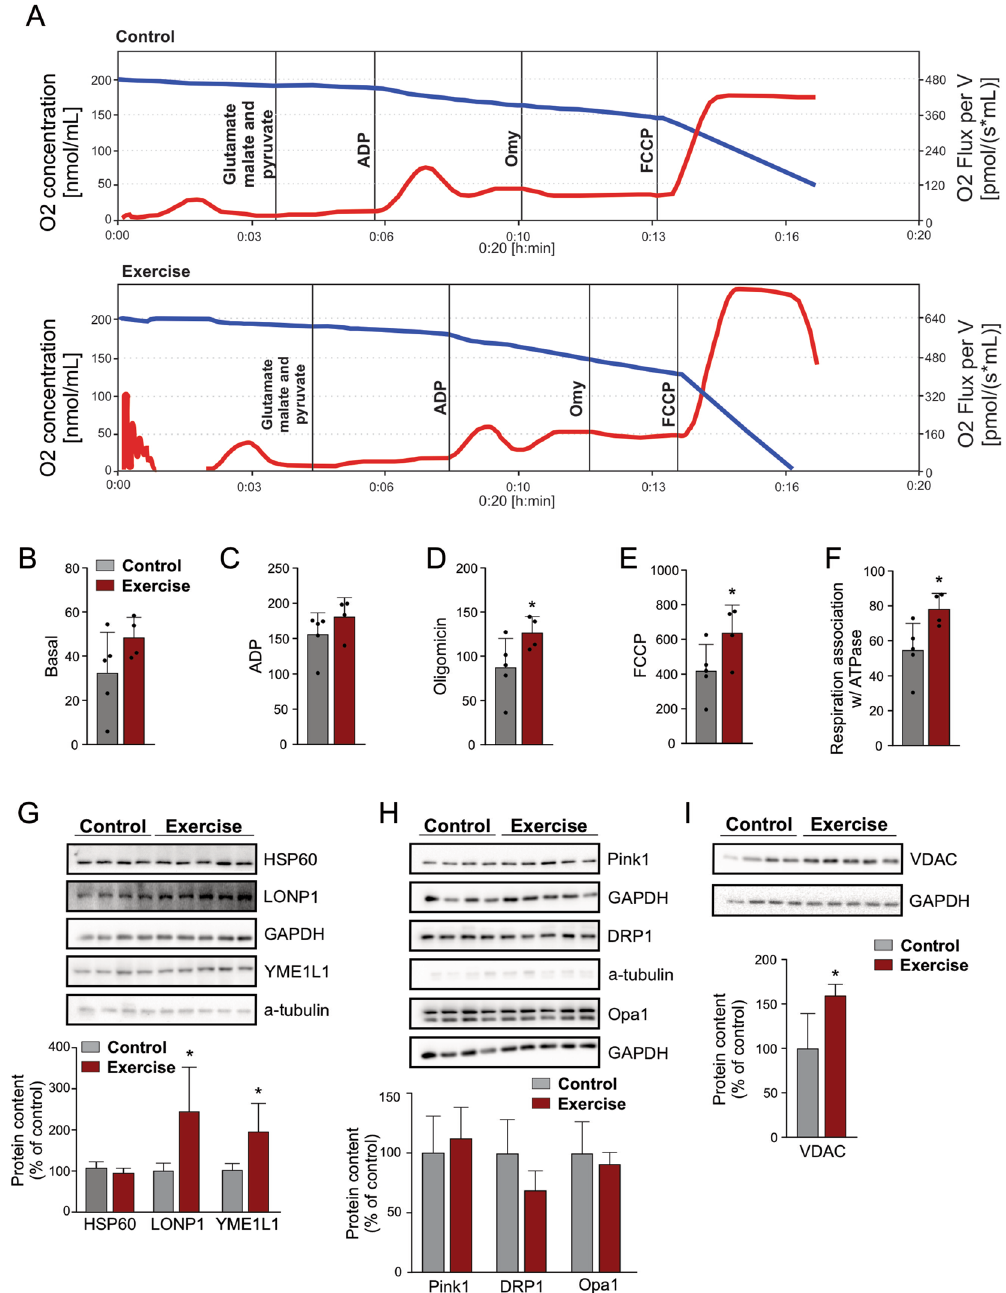
Figure 4. Mitochondrial markers and oxygen consumption analysis. ( A ) Linear O 2 consumption graphs from control and exercise groups. ( B ) Basal levels of oxygen consumption. ( C ) Respiration stimuli after ADP addition. ( D ) Inhibition of mitochondrial respiration after oligomycin addition. ( E ) Maximal capacity of the electron transfer system after uncoupler FCCP addition. ( F ) Mitochondrial respiration capacity that is associated with ATP synthesis (Complex V) acquired by oligomycin values minus basal values (n = control, n = 5 and exercise, n = 4 in B – F ). Western blot showing hypothalamic protein content of ( G ) UPR mt markers (control, n = 4, and exercise, n = 5). ( H ) Pink1, DPR1, and Opa1 (control, n = 4, and exercise, n = 5). ( I ) VDAC (control, n = 4, and exercise, n = 5). “Student’s t-test” (one-tailed B – F ; two-tailed G – I ). * p < 0.05 versus control group. Full- lenth blots are presented in Supplementary Figure S4. Figures ( B – I ) were created in CorelDRAW 2019 software (version 21.0.0.593—https ://www.corel